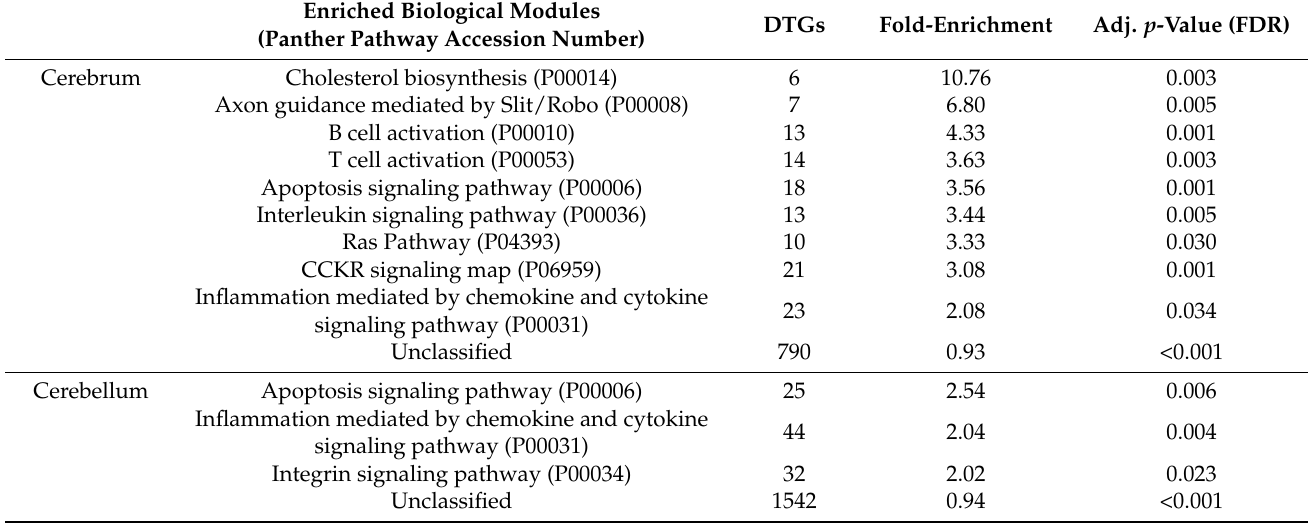
Table 1. Pathways affected by differentially transcribed genes (DTGs) in T. canis -infected cerebra and cerebella. Note that no pathways were statistically significantly overrepresented during T. cati